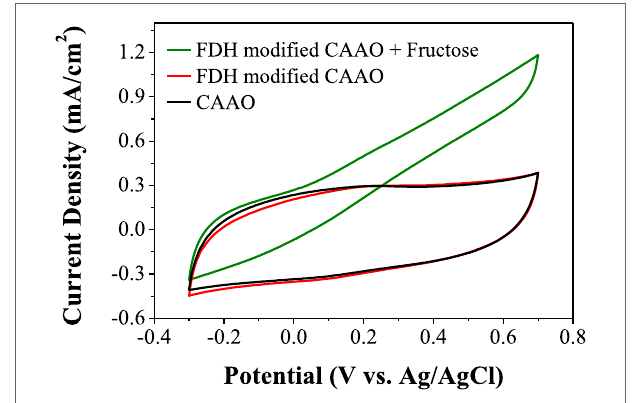
FigUre 9 | cyclic voltammograms of caaO films loaded with FDh using the electrostatic attraction method